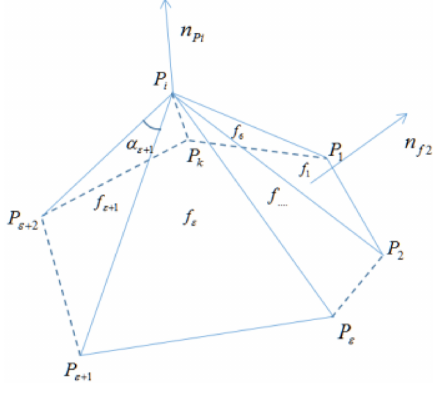
Figure 11. Schematic diagram of the solution to the vertex normal of the spatial triangle mesh